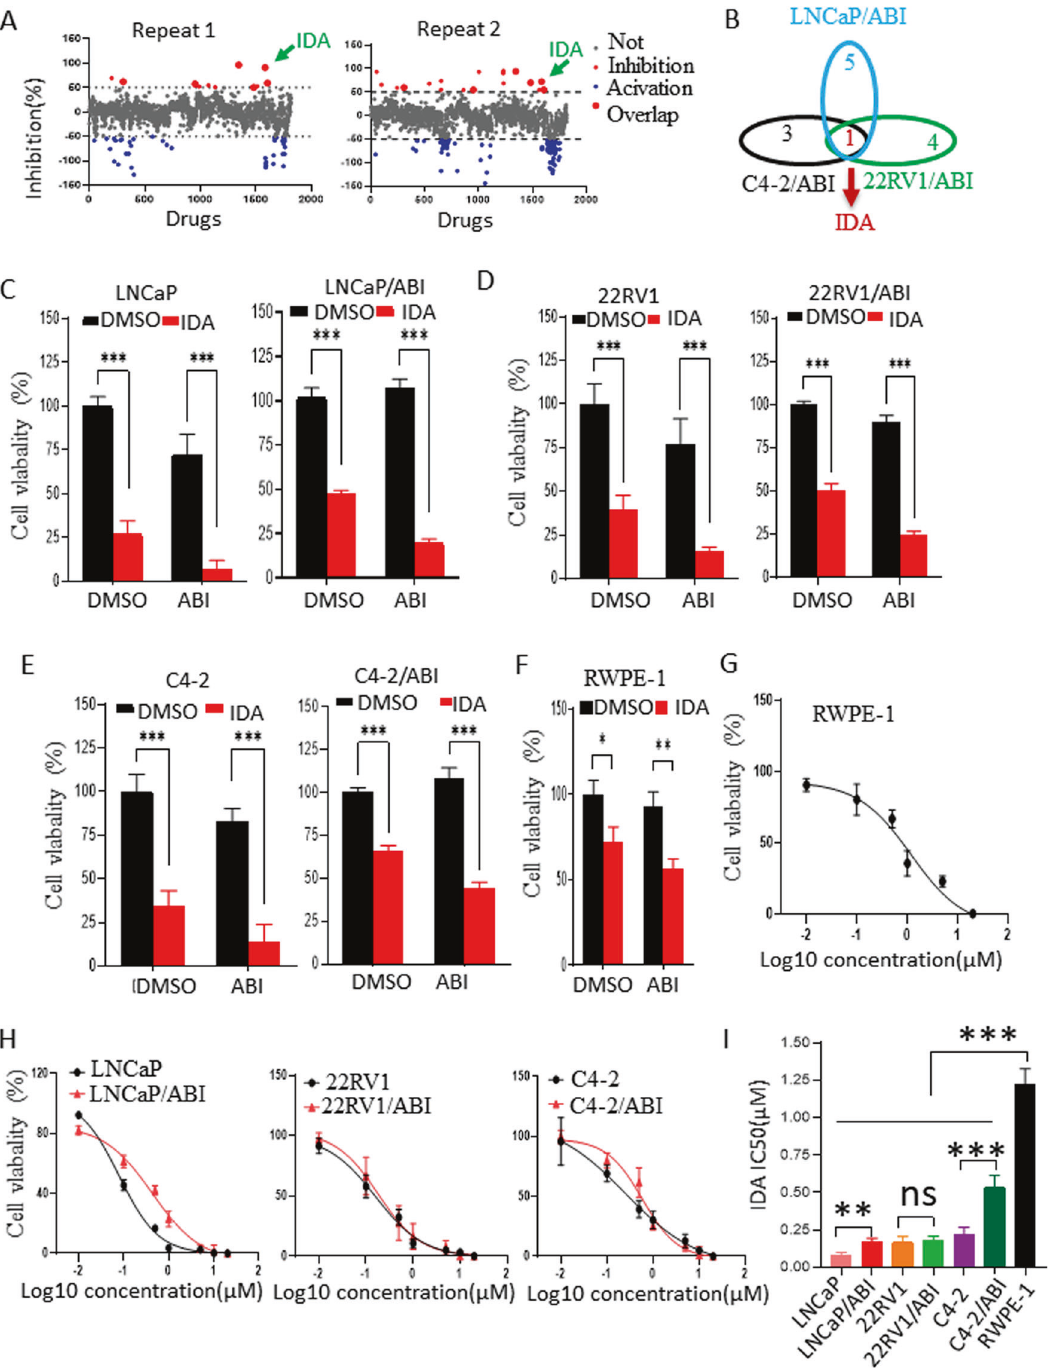
Fig. 1 Identi fi cation of drugs combats abiraterone resistance using a high-throughput assay. A LNCaP/ABI cells were seeded in 96 wells and treated for 24 h with an FDA-approved drug library, including 1815 drugs ( n = 2). Cell viability was determined by CCK-8 assay. B C4-2/ABI and 22RV1/ABI cells were treated with the six drugs (i.g. Otilonium, Idarubicin, Aurano fi n, Sita fl oxacin, Pyrvinium pamoate, and Erda fi tinib) for 24 h. Cell viability was determined by CCK-8 assay. The Venn diagram indicates that IDA is a candidate drug for overcoming abiraterone resistance in LNCaP/ABI, C4-2/ABI, and 22RV1/ABI cells. C – F Abiraterone-resistant cell lines (LNCaP/ABI, 22RV1/ABI, and C4-2/ABI), the parental control cell lines (LNCaP, 22RV1, and C4-2), and RWPE-1 cells were treated with DMSO, IDA, ABI, or a combination of ABI and IDA for 24 h. Cell viability was determined by the CCK-8 assay ( n = 6). G – I Abiraterone-resistant cell lines (LNCaP/ABI, 22RV1/ABI, and C4-2/ABI), the parental control cell lines (LNCaP, 22RV1, and C4-2), and RWPE-1 cells were treated with indicated concentration (i.g., 0 μΜ , 0.01 μΜ , 0.1 μΜ , 0.5 μΜ , 1 μΜ , 2 μΜ , 5 μΜ , 10 μΜ , 20 μΜ ) in the presence of abiraterone (10 μΜ ) for 24 h. Cell viability was determined by CCK-8 assay( n = 6). IC 50 was determined by dose-response curves. Data are presented as means ± s.e.m. The asterisks indicate signi fi cant differences (two-way ANOVA, * p < 0.05, ** p < 0.01, *** p <